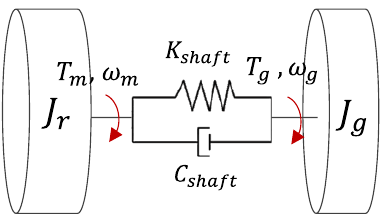
Figure 2. Drivetrain based on the two-mass shaft model.